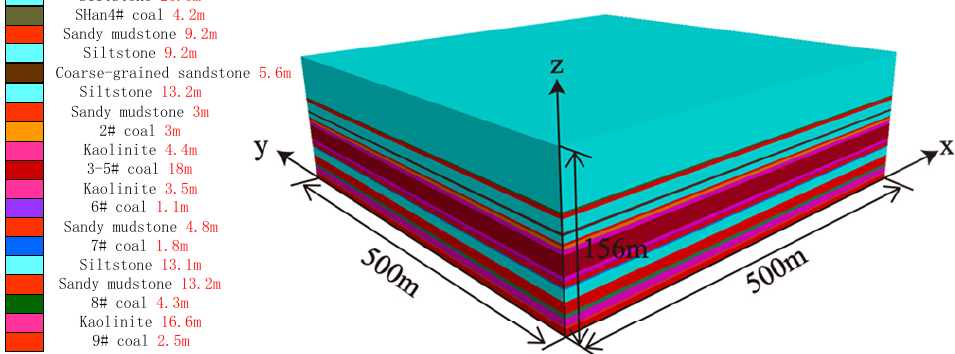
Figure 4. A figure of the numerical model.